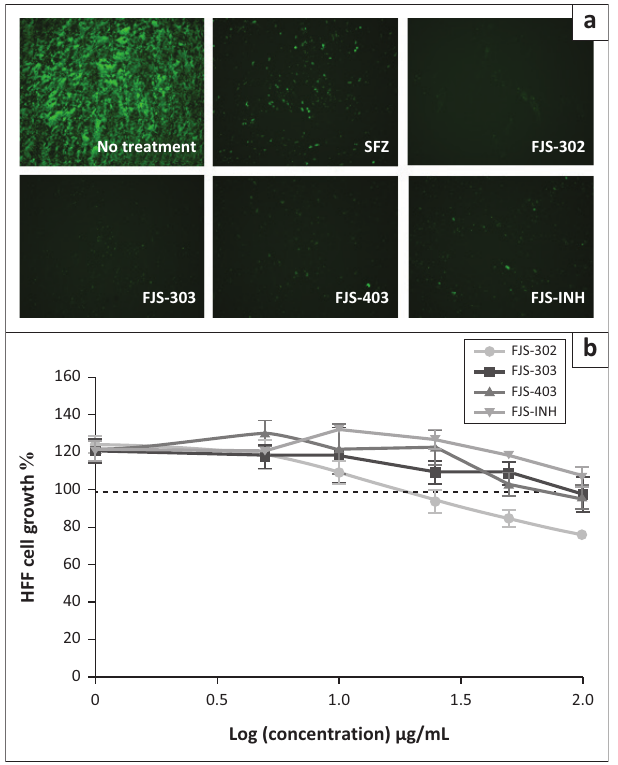
FIGURE 1: Anti- Toxoplasma gondii activity of FJS-302, FJS-303, FJS-403 and FJS- INH on RH-GFP and their cytotoxicity. (a) Representative images of T. gondii RH- GFP-infected HFF cells treated for 72 h with sulphadiazine (1 mg/mL), FJS-302 (50 µ g/mL), FJS-303 (50 µ g/mL), FJS-403 (50 µ g/mL) or FJS-INH (50 µ g/mL). (b) Cytotoxicity testing of HFF cells after treatment with FJS-302, FJS-303, FJS-403 or FJS-INH at concentrations of 0 µ g/mL to 100 µ g/mL for 24 h. Data represent the mean values ± s.d. of three independent experiments.